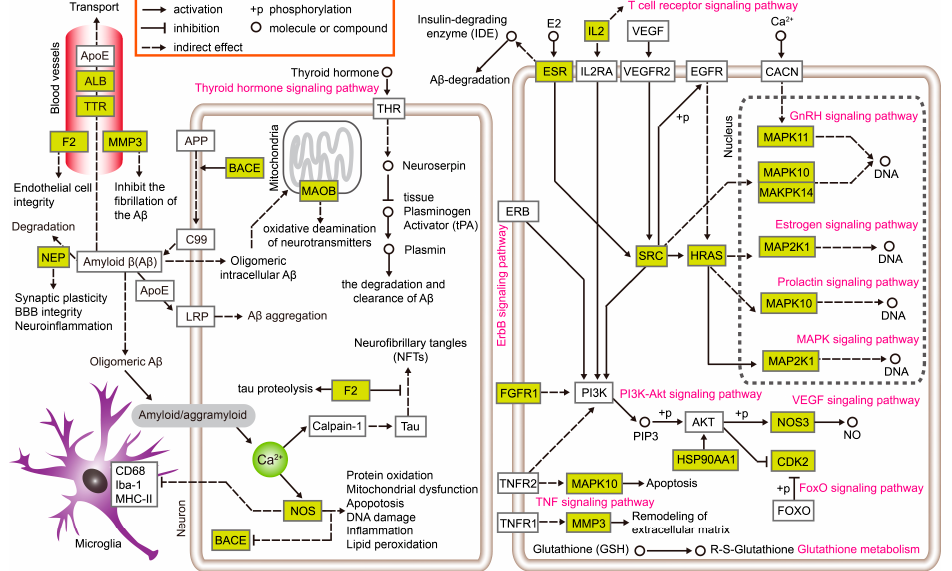
Figure 8. Schematic representation of the interaction effects of enriched KEGG pathway terms and putative target proteins identified in the present study. Green rectangles represent putative target proteins identified in this study. Carmine characters represent enriched KEGG pathway terms. The left panel shows potential MOAs that are directly related to A β synthesis, transport, degradation, and clearance. The right panel shows MOAs that are indirectly linked or irrelevant to A β . Table 3. The mechanisms of 6 putative protein targets related to AD and the current status of research on G. biloba .